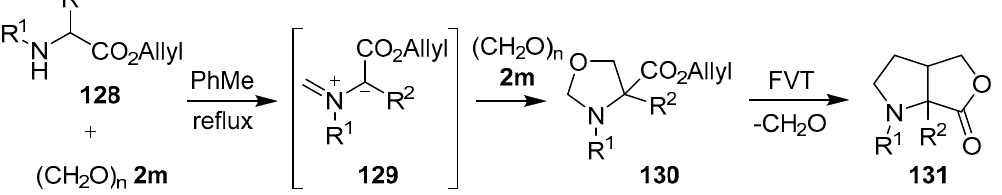
Table 18. Cycloaddition of azomethine ylide 129 to formaldehyde ( 2m ), and subsequent FVT-induced cycloreversion-intramolecular cycloaddition (Scheme